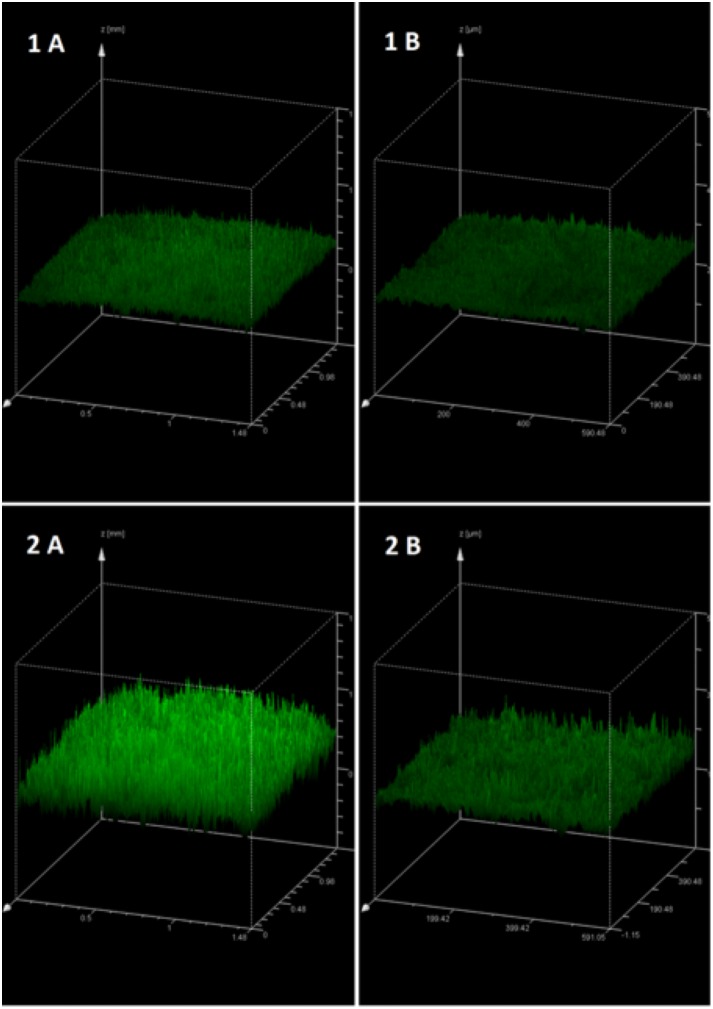
3D CLSM image showing fluorescence intensity at each image layer, providing a visual representation of surface morphology.Film coat consisting of Kollicoat IR 20% w/w and riboflavin 5’-monophosphate sodium 0.5% w/w as a fluorescent dye. Tablets coated by fluidised bed coating method at defined droplet sizes: 20μm (1) and 70 μm (2). Images were taken at 10x (A) and 25x (B) magnification.